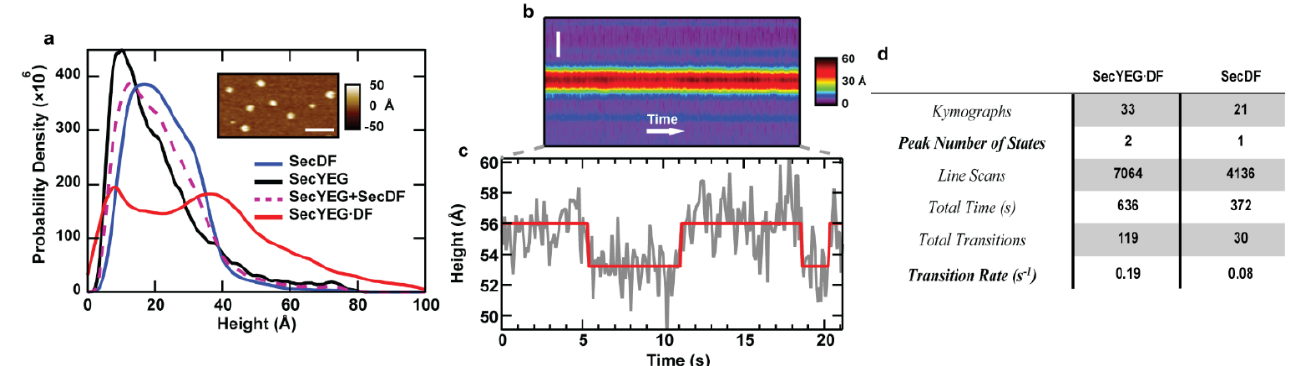
Figure 6. Basal conformational dynamics of SecDF co-assembled with SecYEG. ( a ) Smoothed histograms of membrane protein protrusions emanating from SecYEG alone ( N = 3113; black), SecDF alone ( N = 15,957; blue), the normalized summation of the previous two histograms (SecYEG + SecDF; purple dashed), or the co-assembled combination SecYEG·DF ( N = 10,118; red). ( a , inset) AFM image showing several SecYEG·DF features. The lateral scale bar is 100 nm. ( b , c ) Kymograph of a single SecYEG·DF protrusion. The spatial axis is vertical (scale bar is 50 nm), and the time is horizontal (90 ms per line), the data is shown (grey) and the fit (red). ( d ) Summary of a number of states across all kymographs. SecYEG·DF kymographs are more likely to exhibit two or more states, indicative of enhanced conformational dynamics in comparison to SecDF alone. Additionally, the co-assembled proteins displayed a greater number of transitions between individual states. Data are adapted from Ref. [40] .